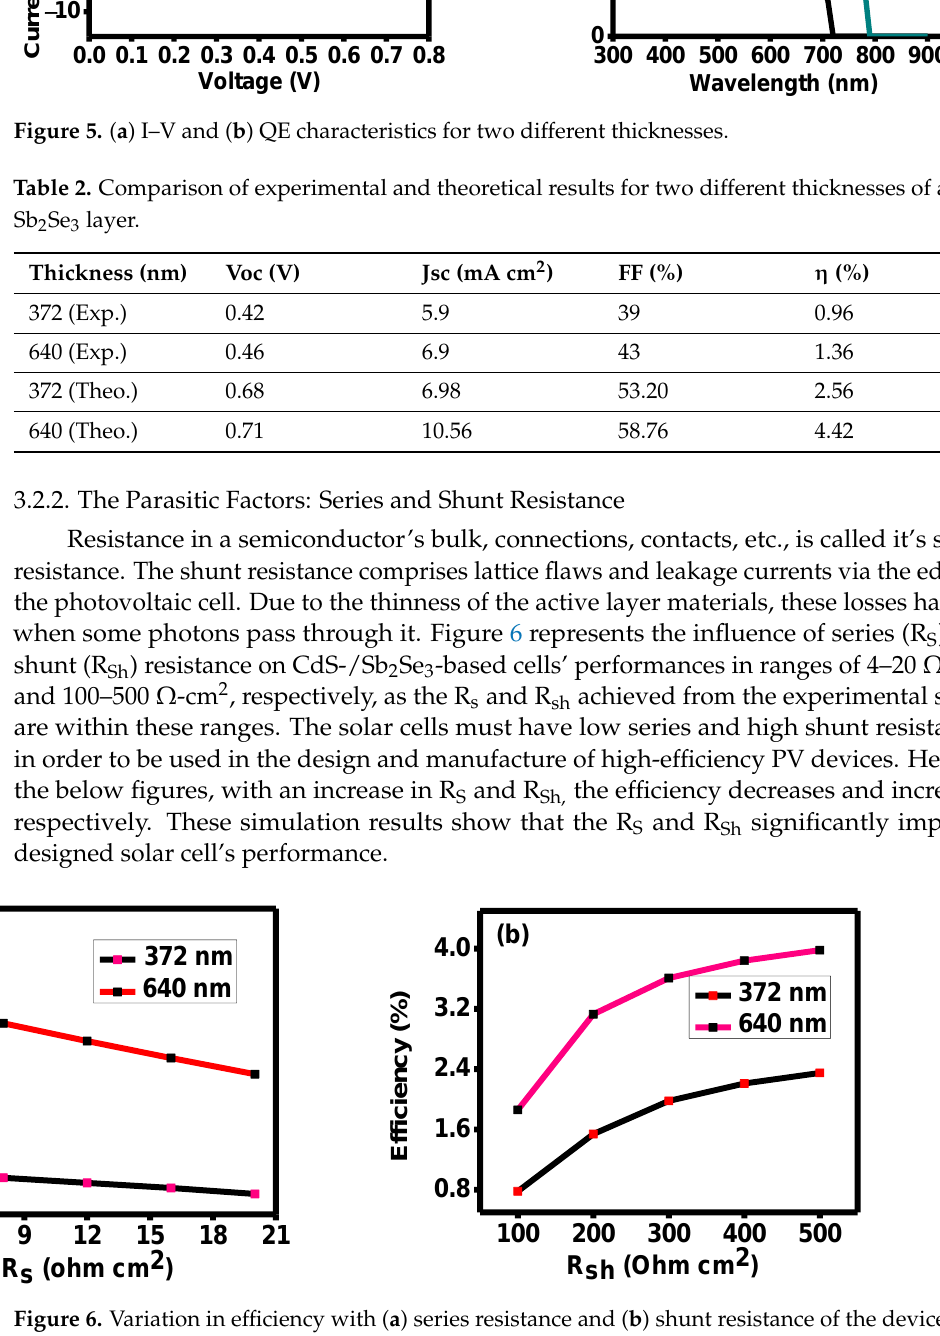
Figure 6. Variation in efficiency with ( a ) series resistance and ( b ) shunt resistance of the device. Table 2. Comparison of experimental and theoretical results for two different thicknesses of active Sb 2 Se 3 layer.